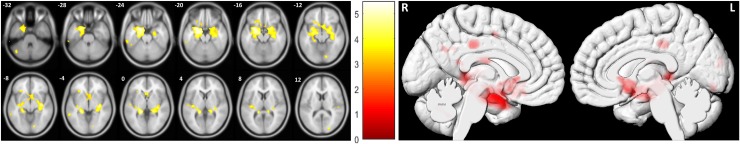
Results showing significant GM differences between the aAD and mAD groups.